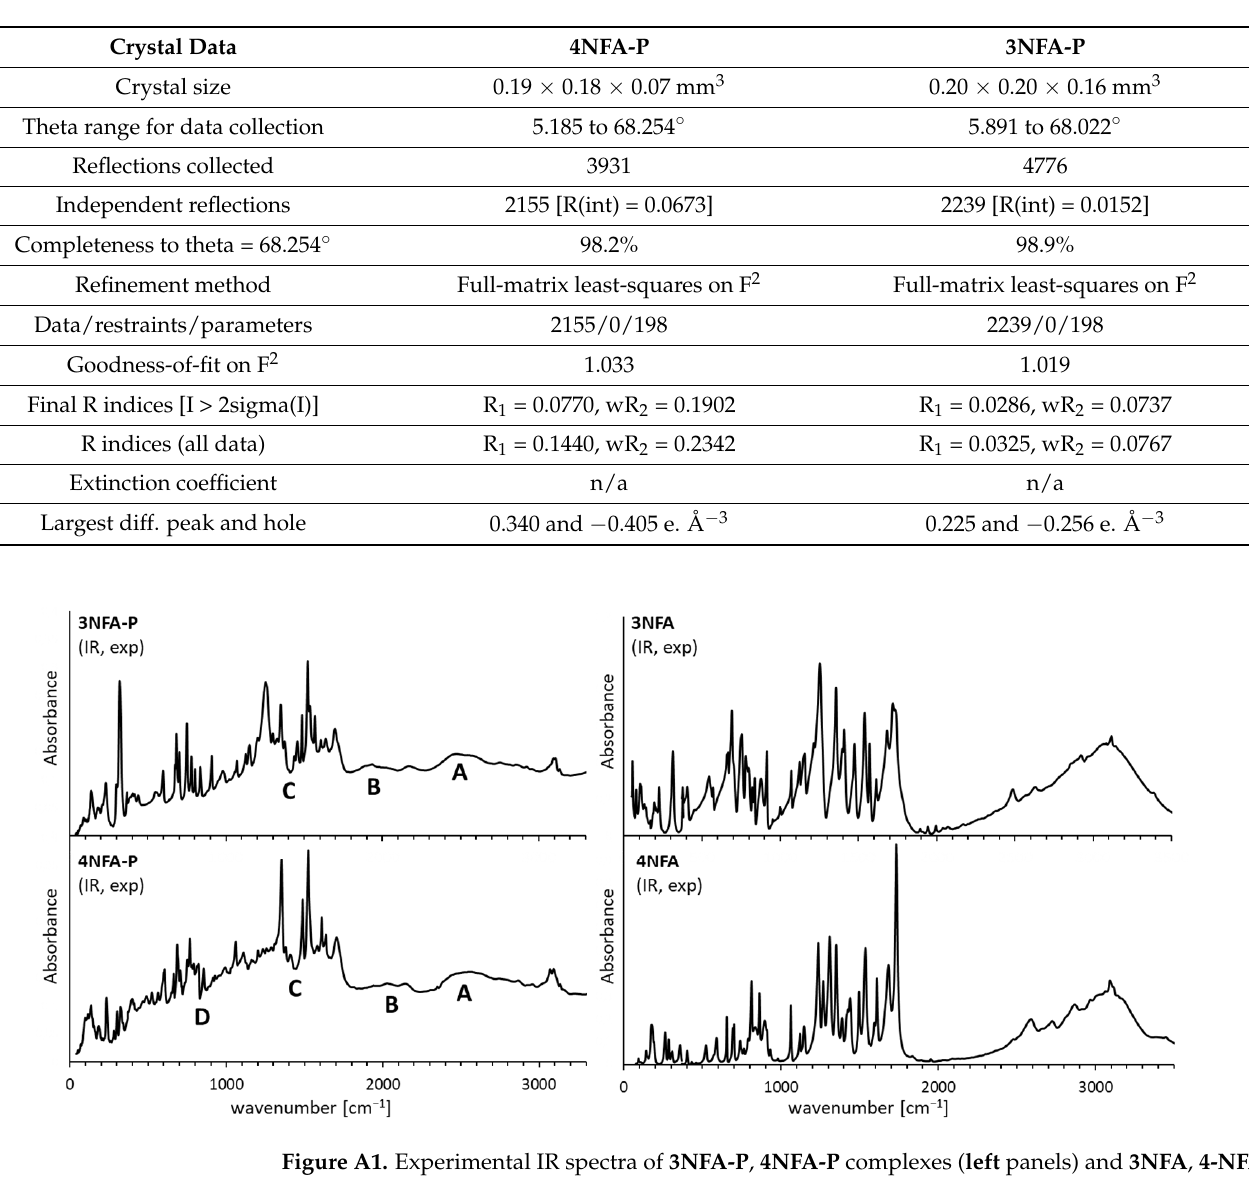
Figure A2. Calculated power spectra of atomic velocity—results of CPMD runs for the 3NFA ‐ P and 4NFA ‐ P complexes in the gas phase and in the solid state (T = 100 K). CPMD power spectra are presented only for the bridged protons vibrational modes.